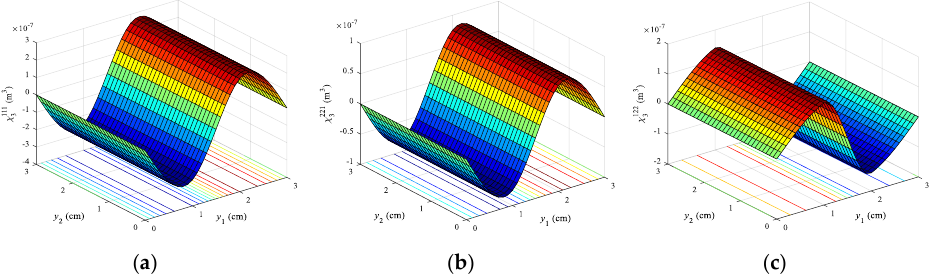
Figure 12. Third-order influence function 𝝌 3 of the CFCF periodic layered plate. ( a ) 𝑚𝑛𝑝 = 111 ; ( b ) 𝑚𝑛𝑝 = 221 ; ( c ) 𝑚𝑛𝑝 = 122 .